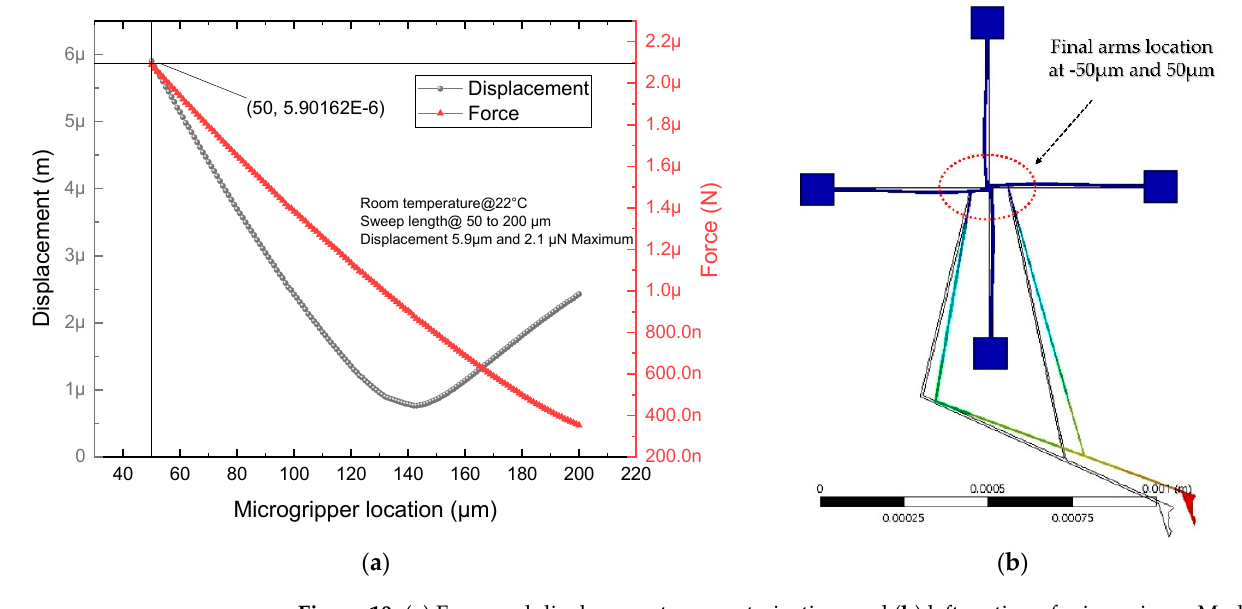
Figure 10. ( a ) Force and displacement parameterization, and ( b ) left section of microgripper Model 1, with the arm locations on the rotary microactuator.